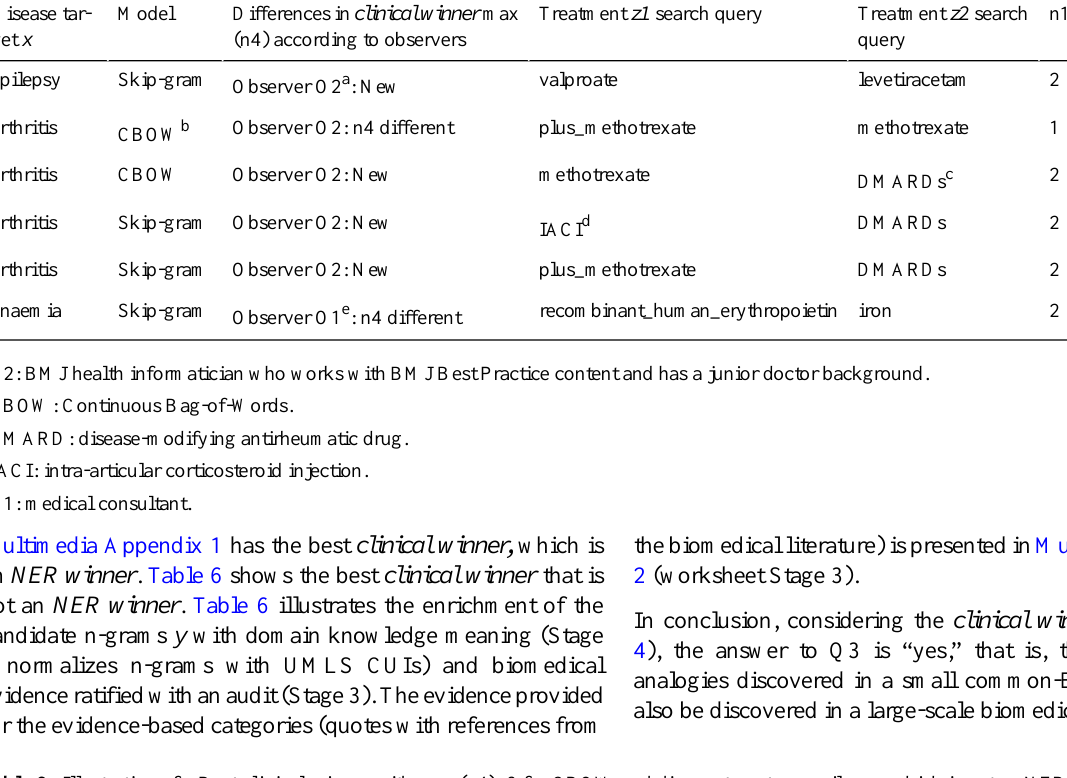
Table 6. Illustration of a Best clinical winner with max (n4)=8 for CBOW and disease target x = epilepsy, which is not an NER